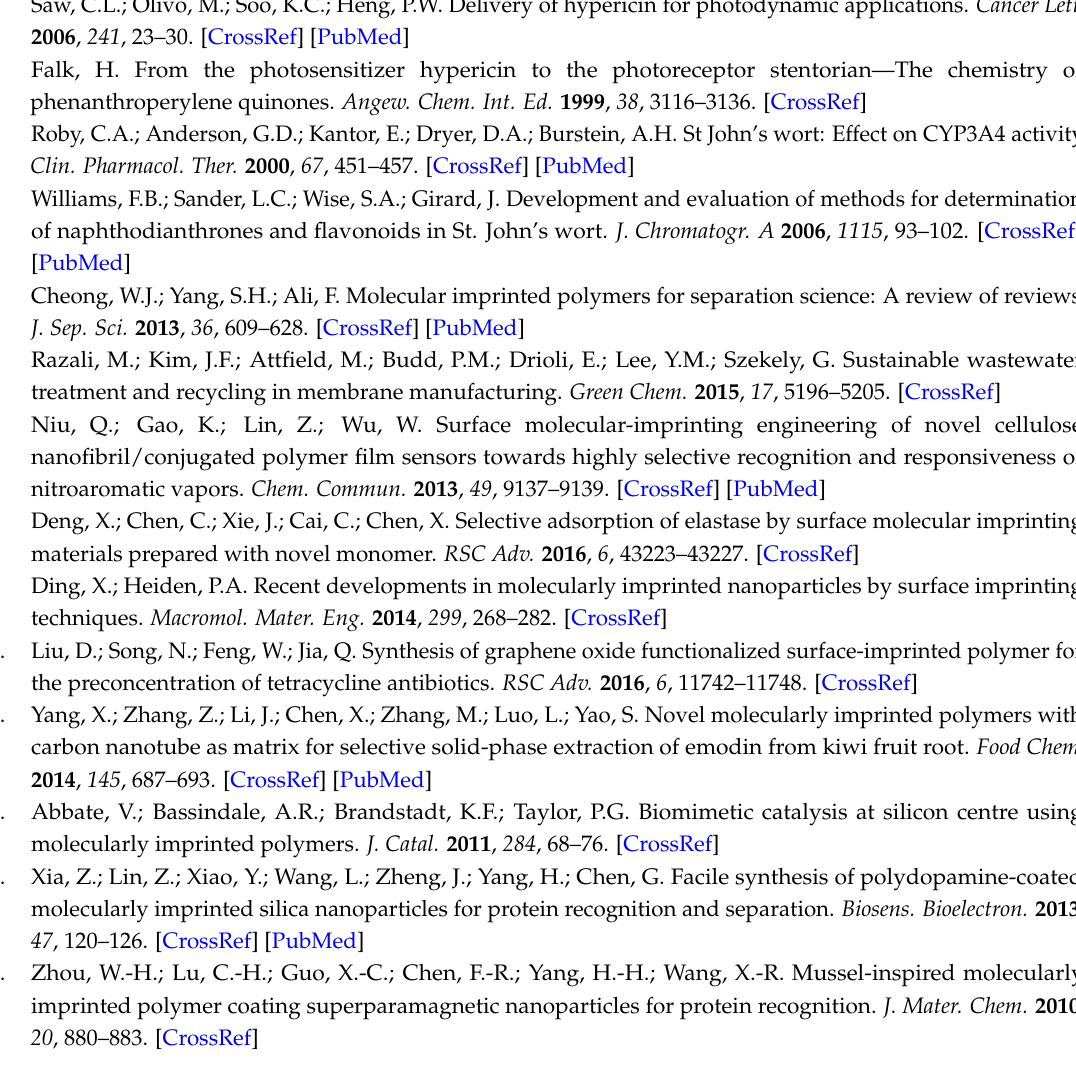
Figure S1: The 1 H-NMR spectrum of emodin anthrone; Figure S2: The 1 H-NMR spectrum of protohypericin; Figure S3: The 1 H-NMR spectrum of hypericin; Figure S4: UV-Vis spectra of hypericin in Tris-HCl and acetone ( v / v = 6:1, pH = 8.0) with or without the presence of dopamine; Figure S5: DLS histograms of MNSs and Fe 3 O 4 @PDA and magnetic response of MNSs; Figure S6: (a) UV-Vis spetra of hypericin, protohypericin and emodin, respectively, (b–d) Standard curves of hypericin, protohypericin and emodin; Figure S7: TEM images of MNSs (a) and their response to magnet in 10 s (b,c); Figure S8: Reusability study of Fe 3 O 4 @PDA/Hyp